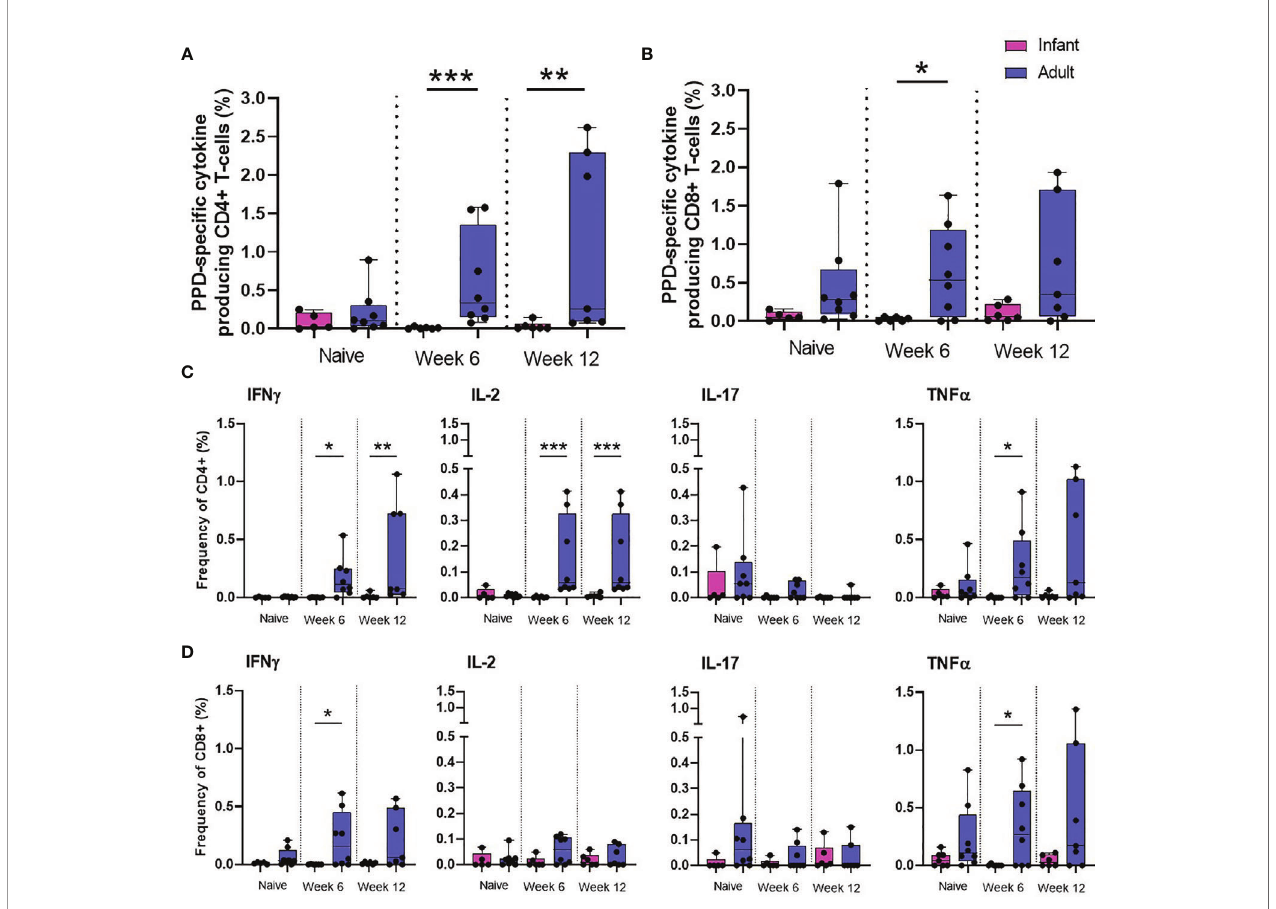
FIGURE 5 | PPD-speci fi c cytokine production by CD4 and CD8 memory T-cells. Total PPD-speci fi c cytokine production by CD4+ and CD8+ T-cells. Dots represent the summed frequency of CD4+ (A) and CD8+ (B) T-cells producing IFN- g , IL-2, TNF- a and IL-17 and CD4+ (C) and CD8+ (D) T-cells producing cytokines IFN- g , IL-2, TNF- a and IL-17 measured in PBMCs collected from individual infant (pink) and adult (blue) animals prior to and following ID BCG vaccination. Box plots show the group median +/- the inter-quartile range, with minimum and maximum values connected by whiskers. Signi fi cant differences measured by Mann-Whitney U-test between the groups are indicated. *p ≤ 0.05, **p < 0.01, ***p <